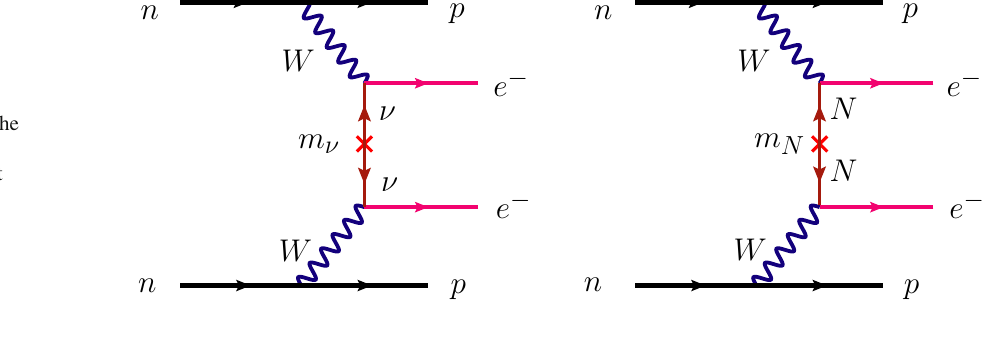
Fig. 9 Feynman diagrams contributing to neutrinoless double beta decay with W − − W − mediation via the exchange of virtual light neutrinos ν (left panel), and the exchange of virtual eV scale sterile-like neutrinos N (right